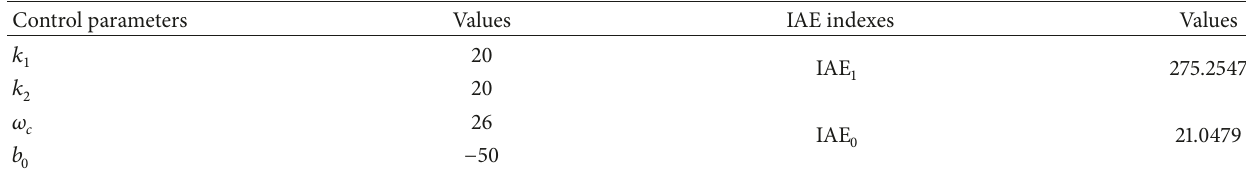
Table 3: Control parameters and IAE values (in presence of sinusoidal disturbance).